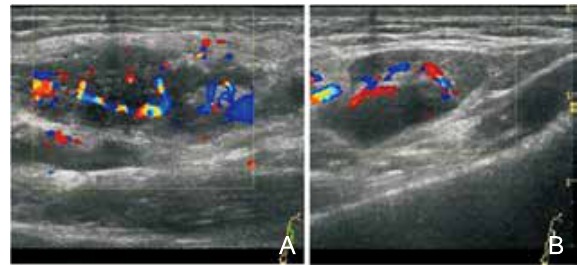
Type II flake-like thickening of lesion of Kimura disease in right elbow (A), with trochlear lymph node involvement (B).